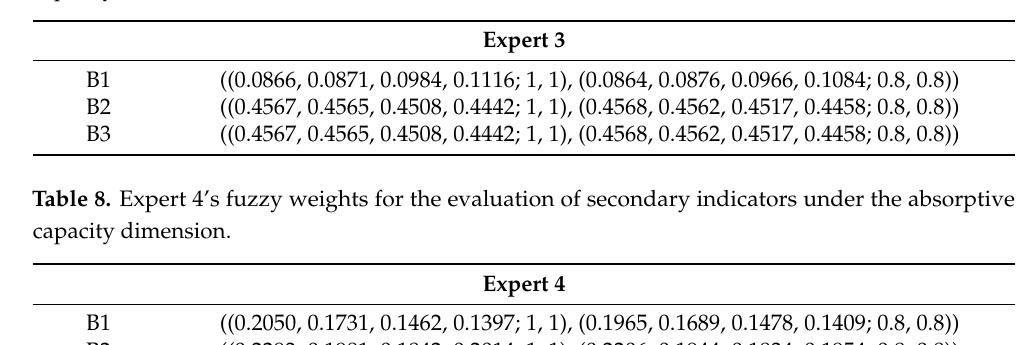
Table 7. Expert 3’s fuzzy weights for the evaluation of secondary indicators under the absorptive capacity dimension.